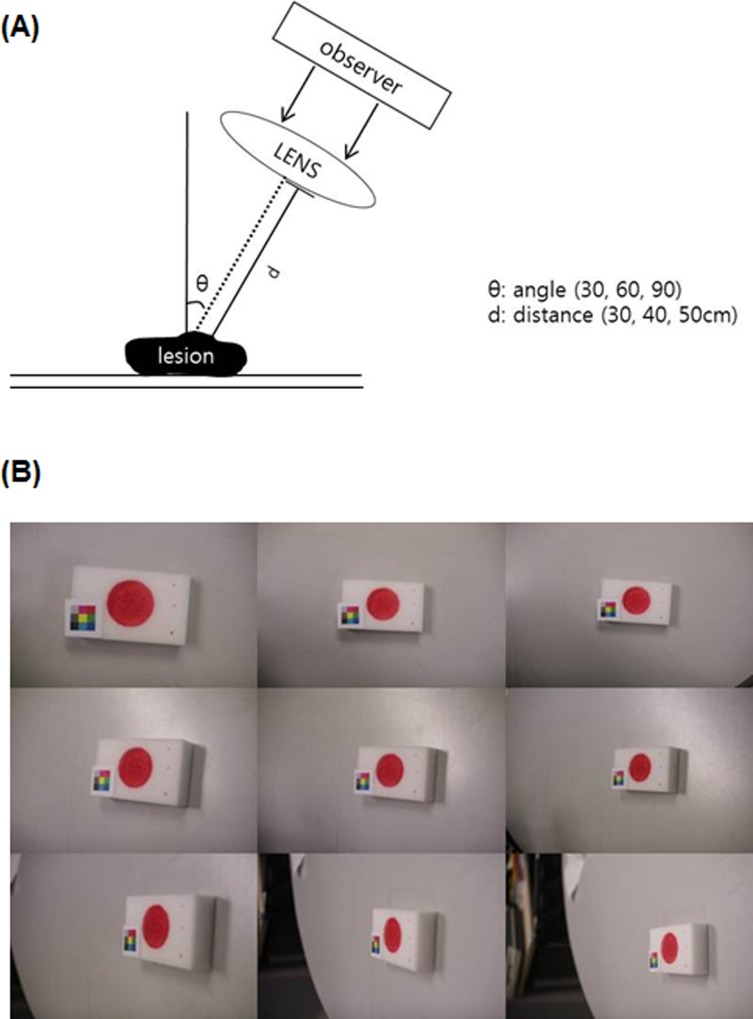
Experimental model for calculating the error rate of color patch method.(A) The capturing system (B) Images captured from 30, 40, and 50 cm distances and at 30, 60, and 90 angles.